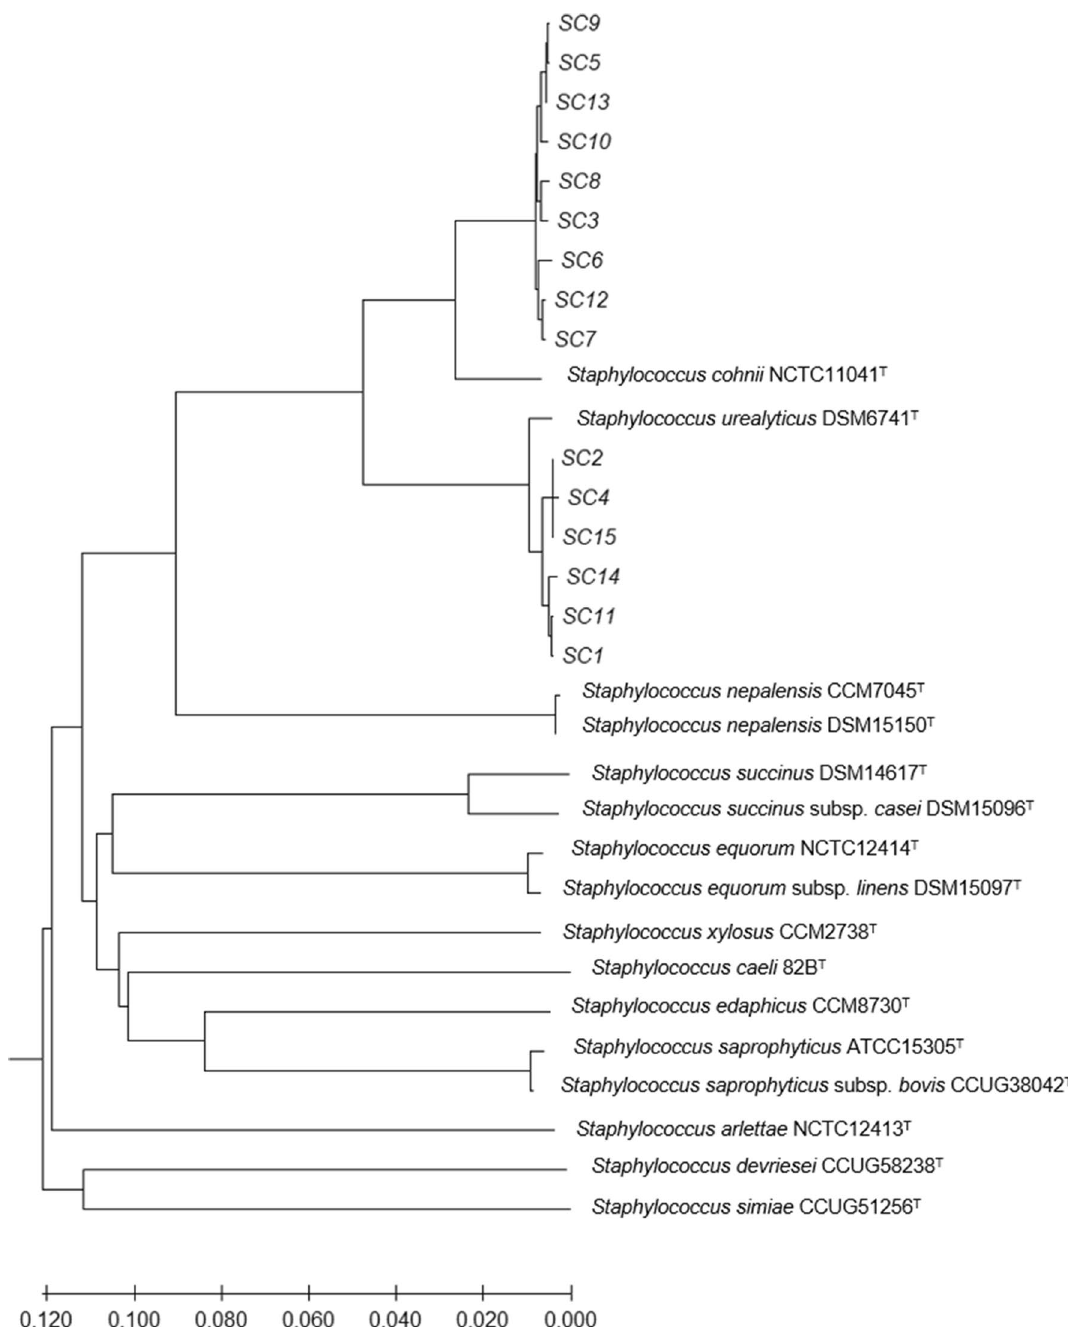
Figure 1. Phylogenetic analysis by TYGS of 15 presumptive S. cohnii isolates from German dairy farms reveals two main clusters of relationship. Clustering of isolates SC1, SC2, SC4, SC11, SC14 and SC15 together with S . urealyticus DSM6718 indicates assignment of these isolates to the